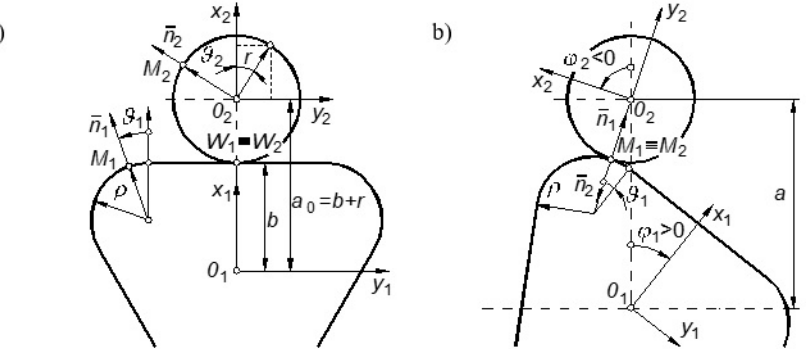
represents the center distance in the transmission.